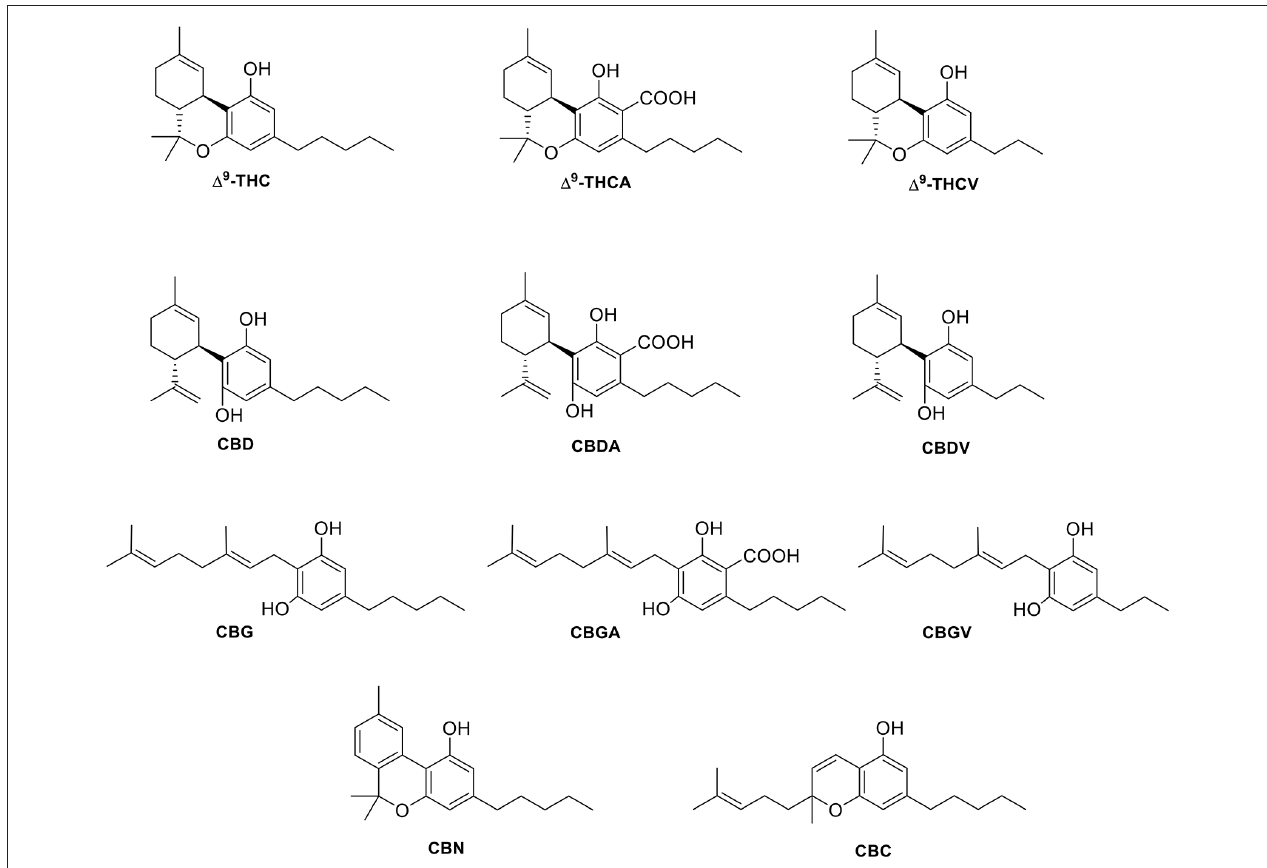
FIGURE 5 | Structure of selected plant cannabinoid ligands that target TRP